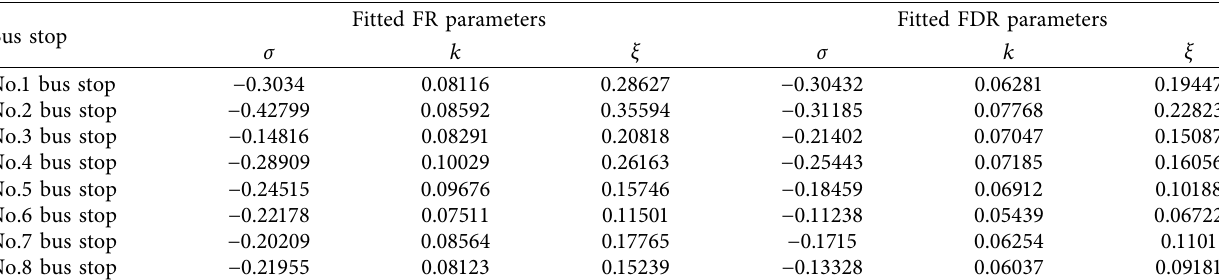
In Figure 11, the “star (with pink color)” and “triangle (with red color)” display the fitted values of R f and R fd at these 17 critical CDF levels, and the “star” and “triangle” connected by a dotted line is defined as an equal correlation pair of R f and R fd for the corresponding critical CDF level.